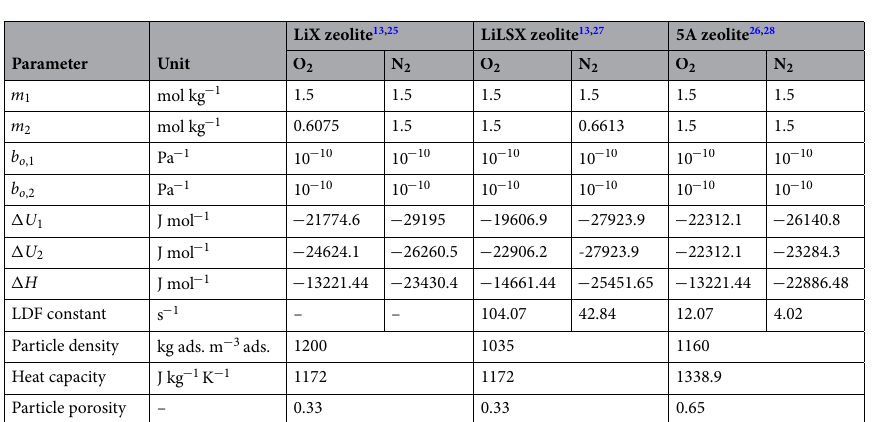
Figure 4. Experimental equilibrium adsorption capacity data and fitted isotherms for candidate adsorbents in adsorption-based MOC. ( a ) LiX, ( b ) LiLSX and ( c ) 5A zeolites with experimental data of Rege and Yang 25 , Zhu et al. 13 and Talu et al. 26 , respectively.